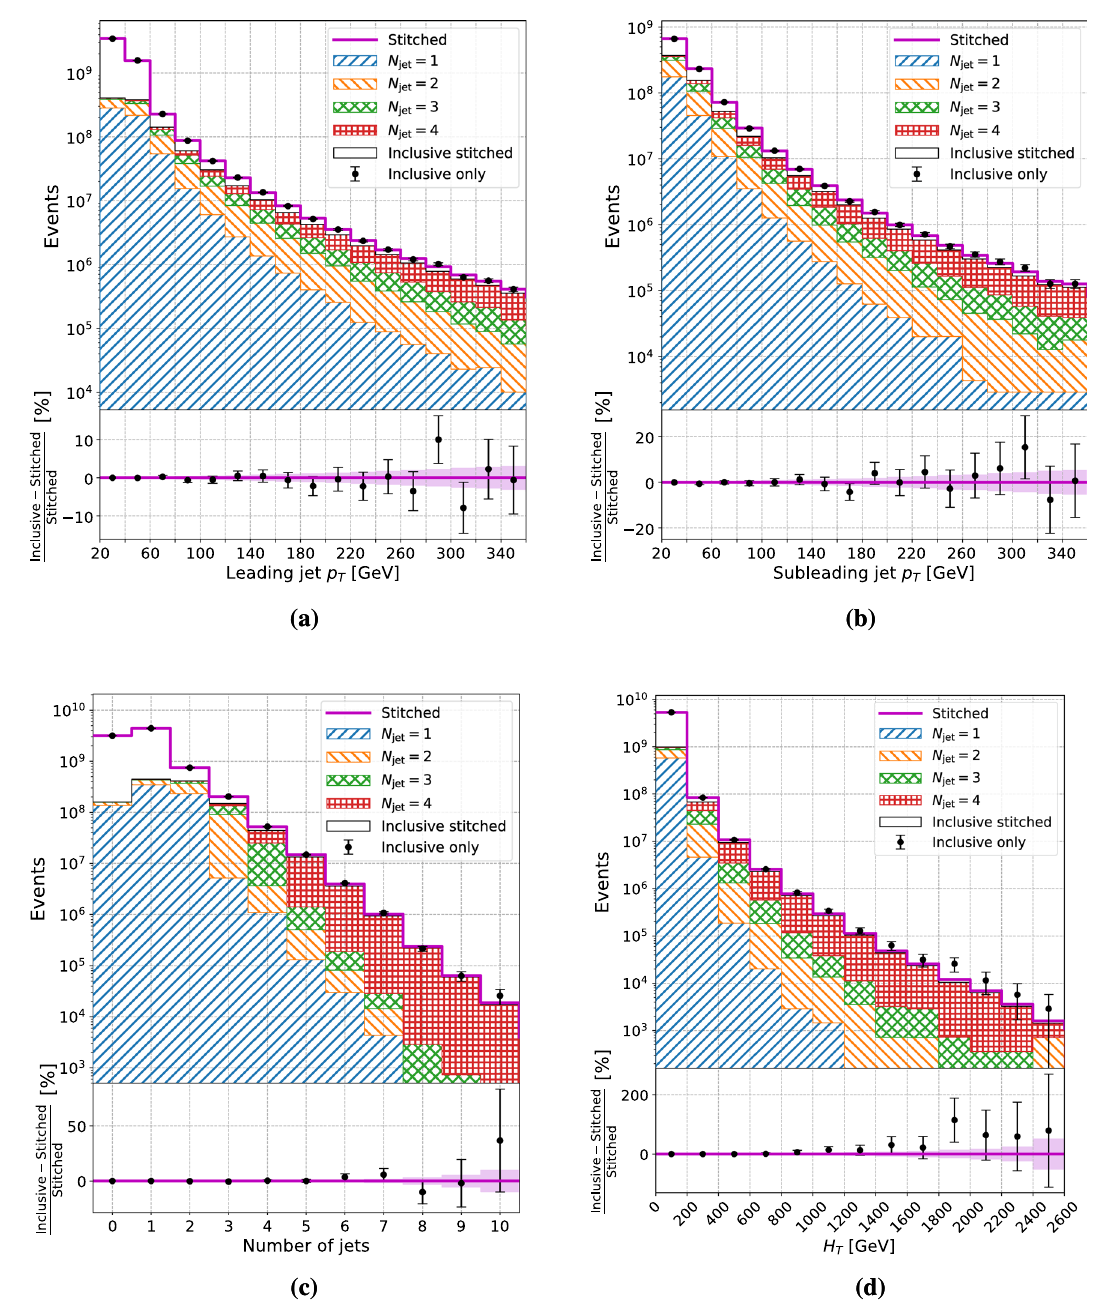
Fig. 1 Distributions in p T of the a leading and b subleading jet, in c the multiplicity of generator-level jets and in d the observable H T , the scalar sum in p T of these jets, for the case of W+jets samples that